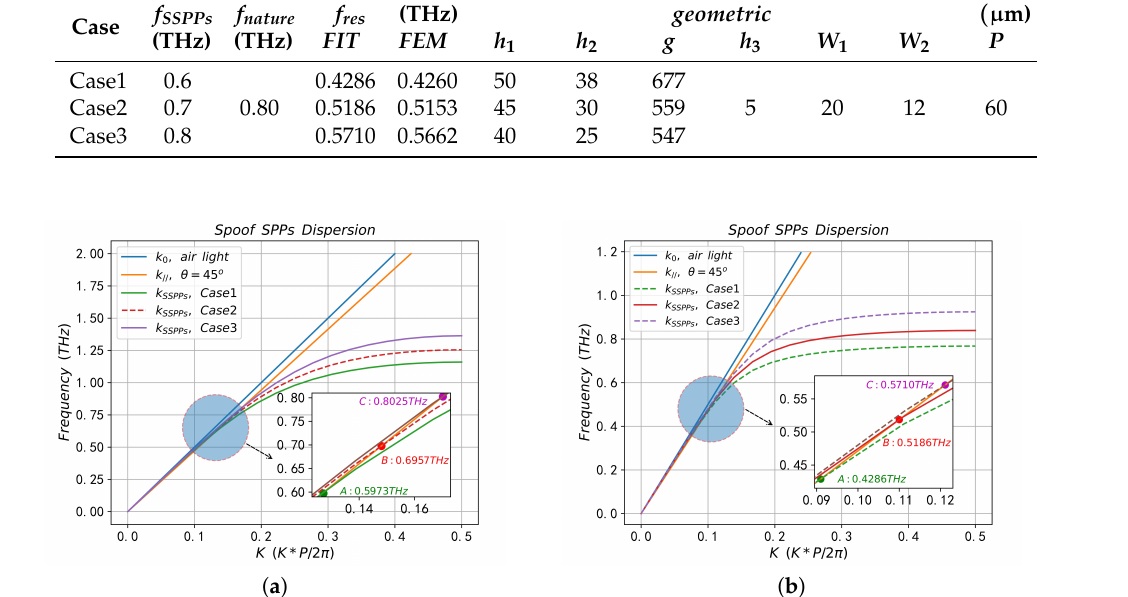
Figure 13. SSPPs dispersion curves corresponding to the di ff erent resonant structures (Case1, Case2 and Case3) without sample ( a ) in Table 4 and with sample ( b ) in Table 5.